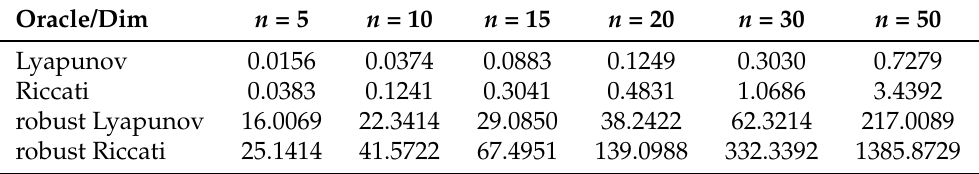
Table 1. Execution time (milliseconds) of the four boundary oracles for various dimensions n .